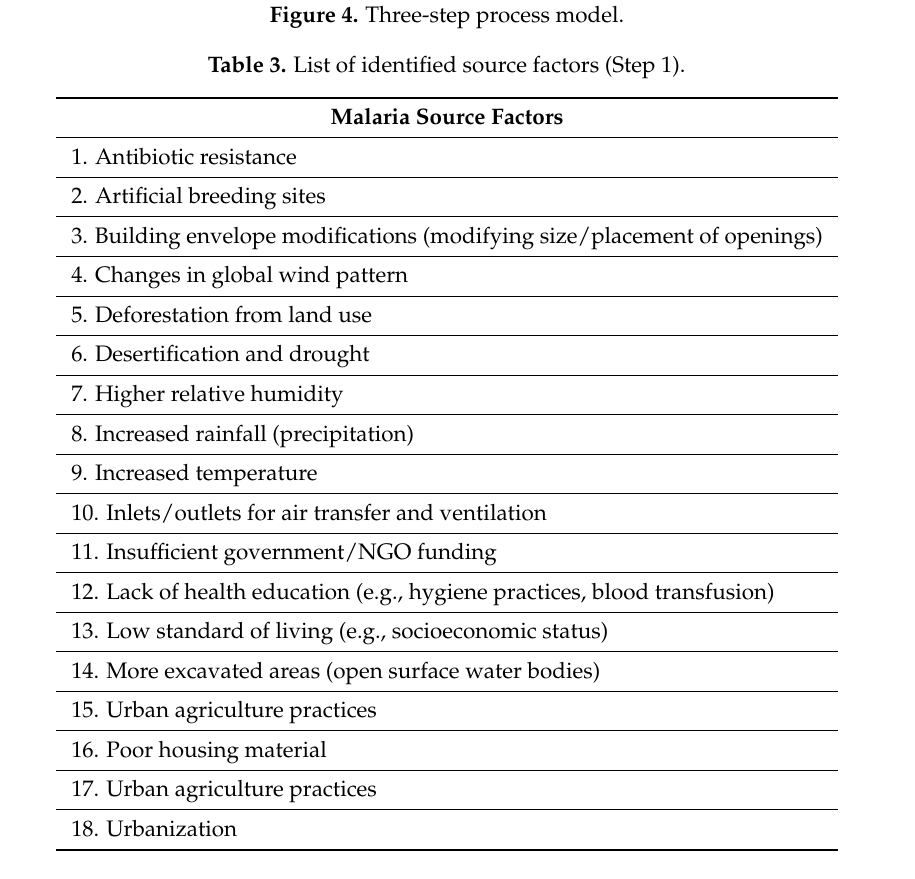
Table 4. List of categorized source factors (Step